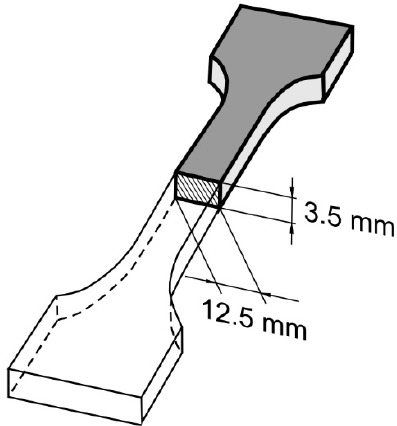
Figure 3. Scheme of the sample with the cross-section dimensions.